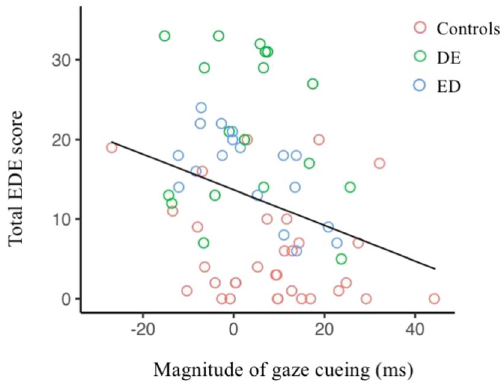
Figure 3. Depicts each participant’s average magnitude of gaze cueing (x-axis) as a function of total EDE-QS score (y-axis). Different coloured data points denote group